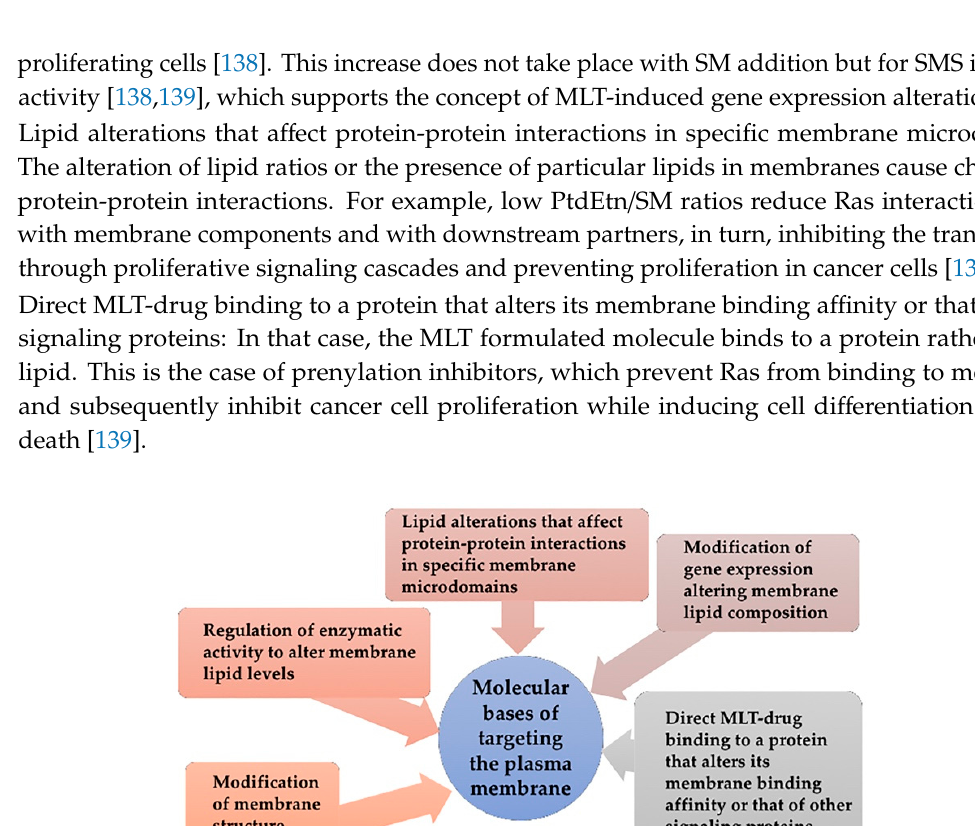
Figure 6. Membrane-Lipid Therapy molecules are currently being developed for several medical conditions.